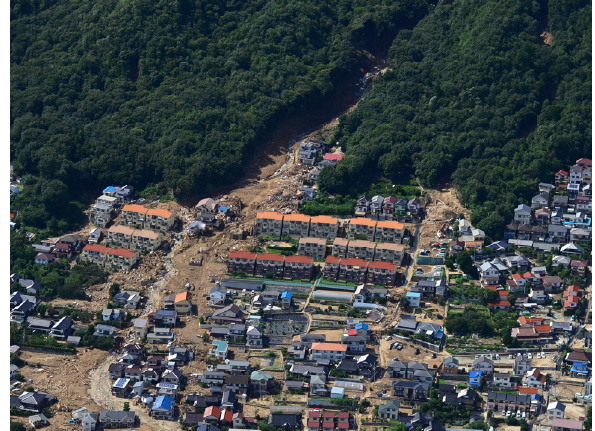
Figure 16. Asaminami Ward Yagi the district (3).